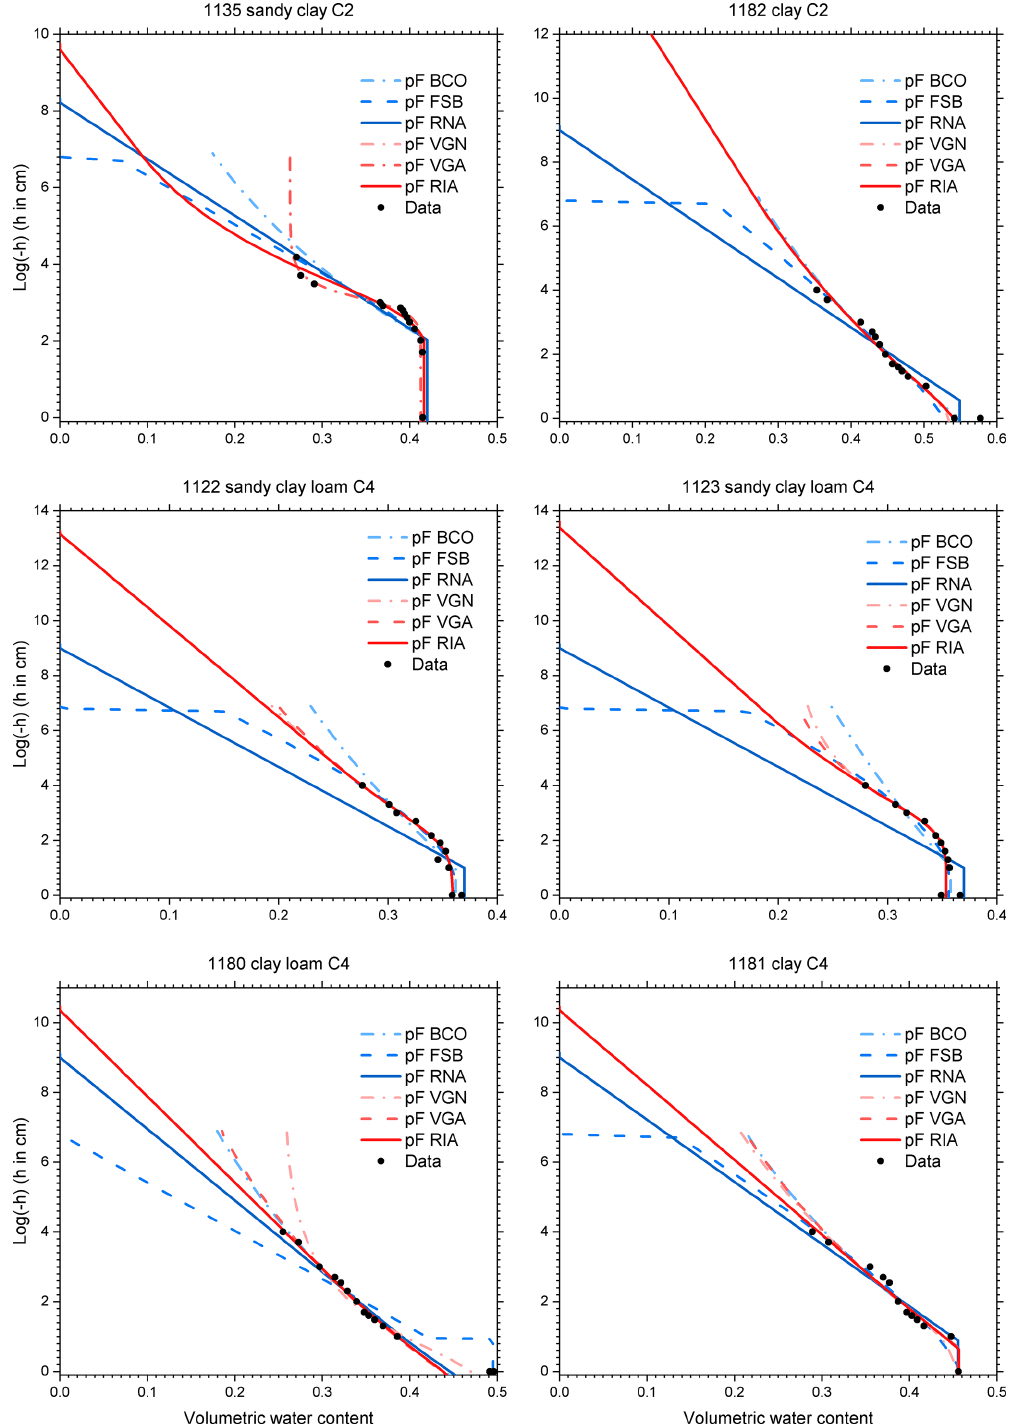
Figure C5. Retention data and fitted soil water retention curves according to six parameterizations for selected UNSODA soils with the C2 or C4 classification of Twarakavi et al. (2010). The parameterizations are explained in the text.